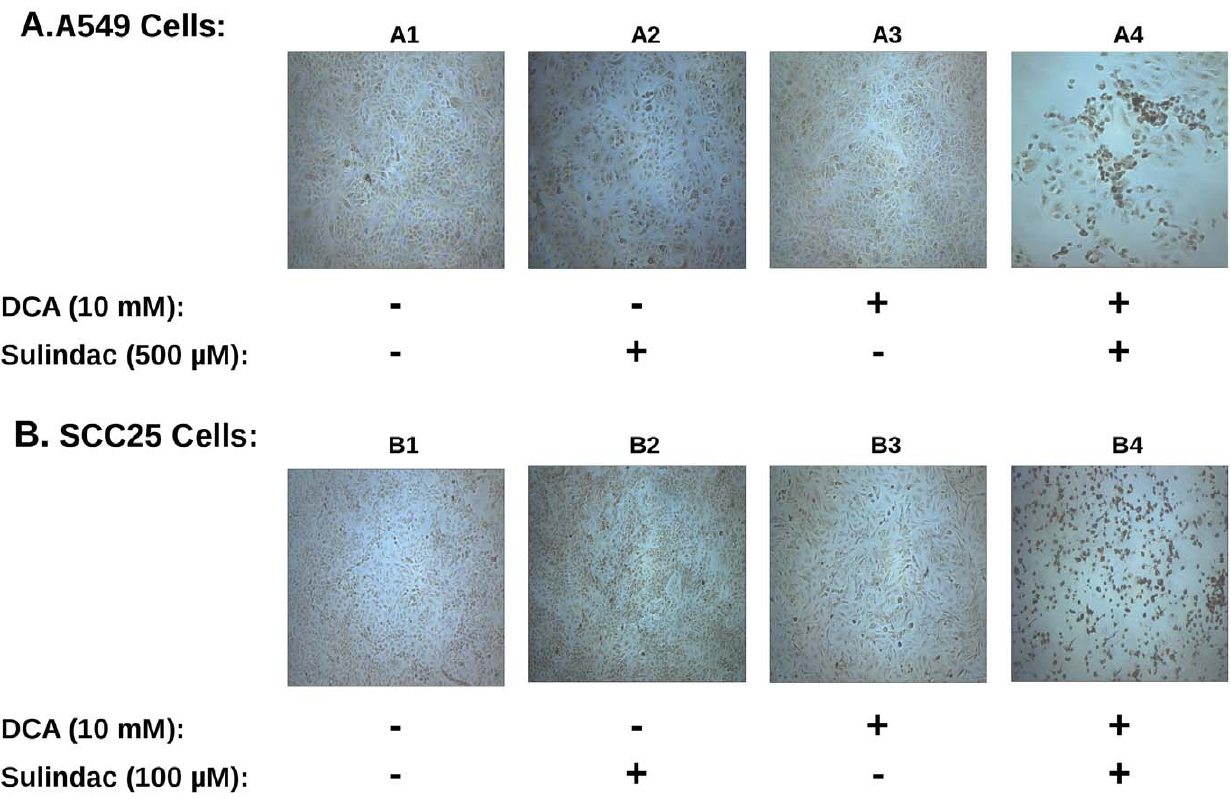
Figure 6. Sulindac in combination with DCA induce apoptosis in cancer cells. Top panels (A) illustrate the results for A549 cancer cells while the bottom panels (B) depict the results for SCC25 cancer cells. The extent of cells undergoing apoptosis was monitored by TUNEL staining of cells treated with no drugs (sub-panels A1 and B1), sulindac alone (sub-panels A2 and B2), DCA alone (sub-panels A3 and B3), and sulindac and DCA (sub- panels A4 and B4). The cells were treated with the indicated drugs as mentioned in the panels, subjected to TUNEL staining, and processed for fluorescent microscopy as described in the Methods. Several independent fields were photomicrographed and representative fields for each condition are shown. Brown-stained cells are indicative of cells undergoing apoptosis.